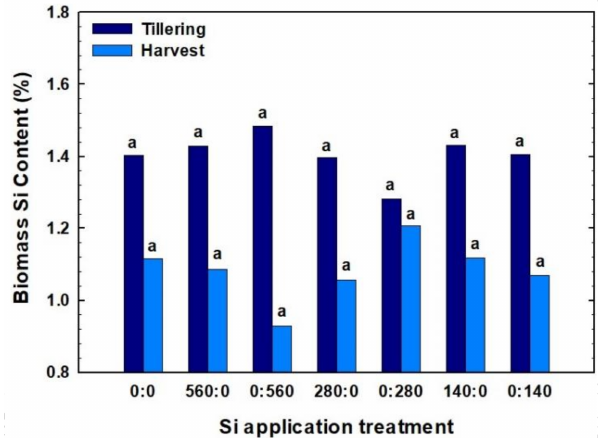
Figure 2. Effect of different Si rates and application time on winter wheat biomass Si content (%) at tillering and before harvest in 2017. Treatments are designated in the format x:y, in which x and y are the fertilizer Si rates in kg Si ha − 1 applied at planting and at tillering, respectively. Bars within the same year followed by the same letter are not significantly different ( p > 0.1) based on a Duncan’s multiple range